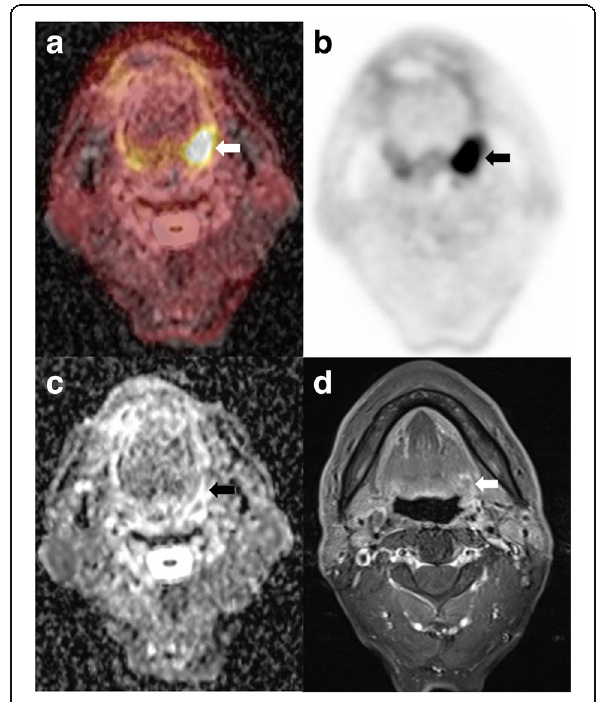
Fig. 4 Case of tonsillar cancer with no evidence of disease predicted by combined PET/MRI parameters but treatment failure predicted by PET parameters. A 66-year-old male underwent preoperative simultaneous 18 F-FDG PET/MRI due to a 3.8-cm-sized left tonsillar cancer. a Fusion image of regional PET with ADC map and b regional PET images showed left tonsillar mass with hypermetabolism (arrows). c ADC map image demonstrated left tonsillar mass with diffusion restriction (arrow). d Gadolinium-enhanced T1 axial image revealed mass with peripheral enhancement (arrow). ADCmean (1443.85), (SUVmax/ ADCmean)×1000 (10.37), (MTV/ADCmean)×1000 (10.69), and (TLG/ ADCmean)×1000 (57.53) predicted no evidence of disease; however, SUVmax (14.97), MTV (15.44), and TLG (83.07) predicted treatment failure. The patient showed no evidence of disease until 41 months follow-up after tonsillar cancer